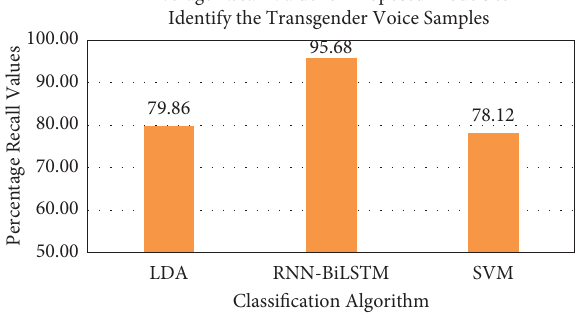
Figure 5: Average recall value for proposed models to identify the transgender voice samples.